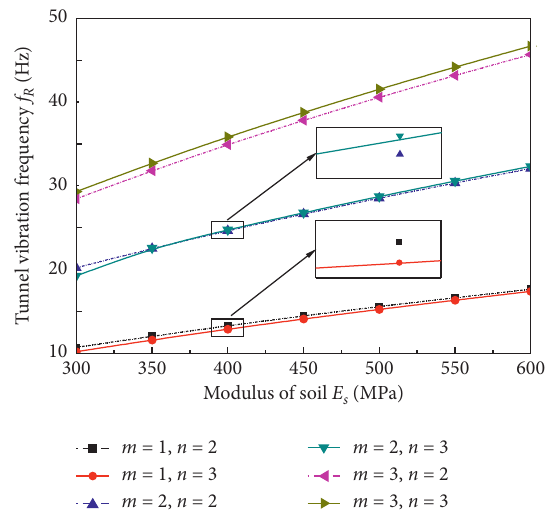
Figure 8: Relationship between natural frequency of the tunnel and tunnel length for different modes, where η � 1.0 × 10 6 Pa · s.